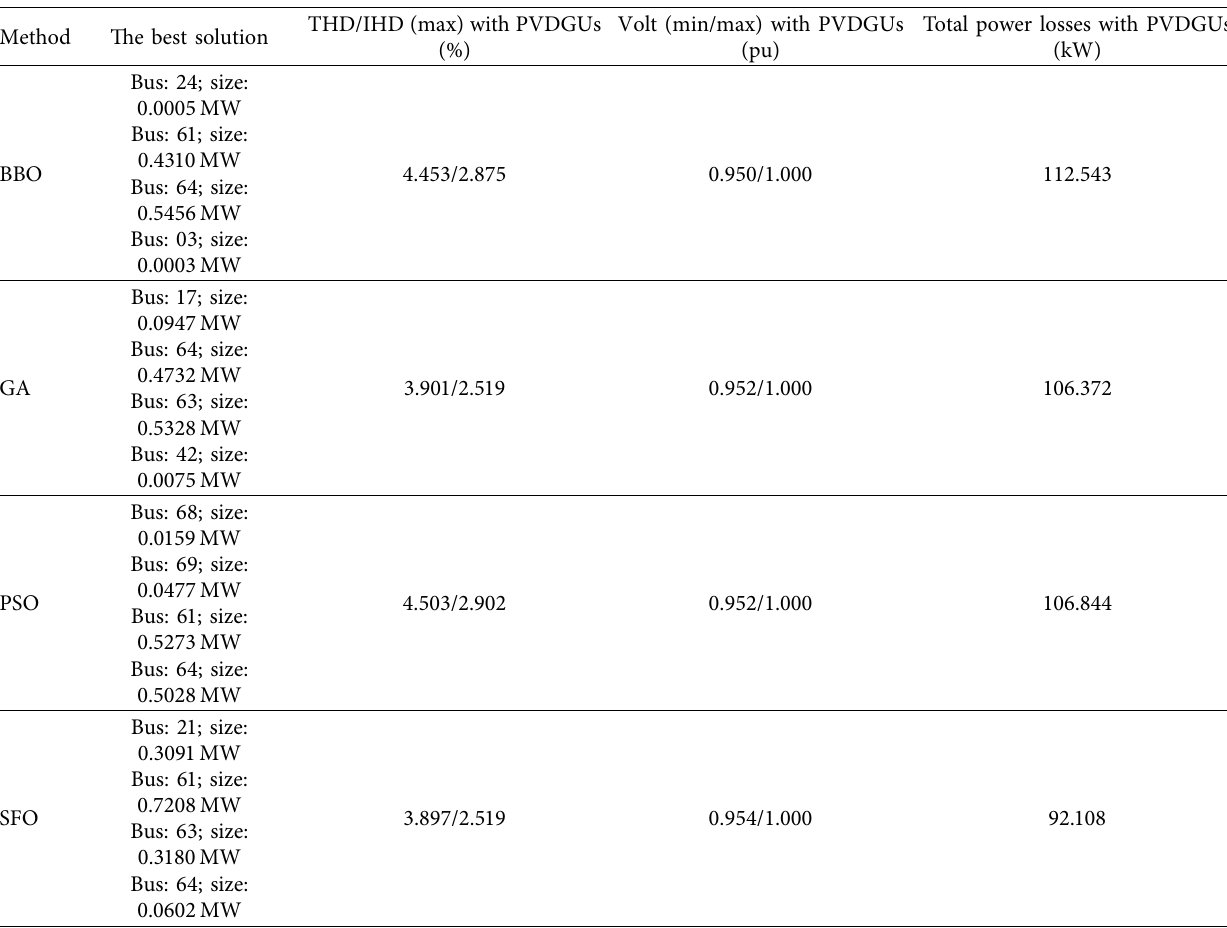
Table 17: The best solutions and the total capacity of PVDGUs found by nine implemented methods for the IEEE 69-bus distribution network in Case